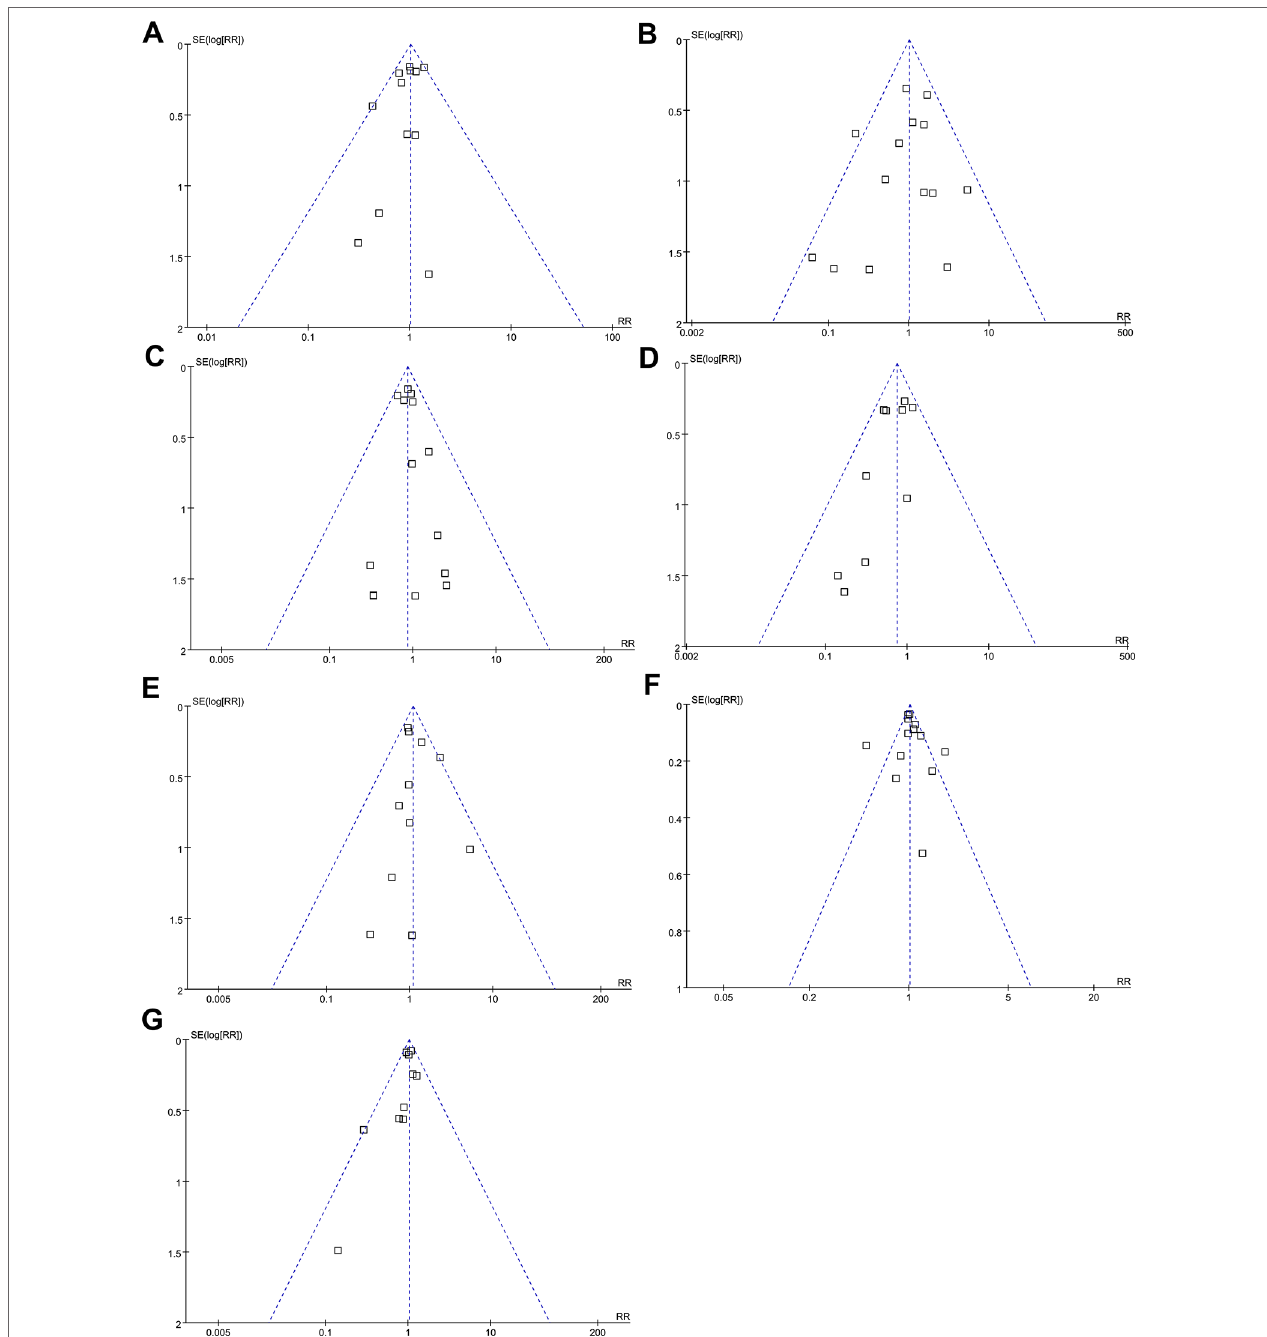
FIGURe 5 | Funnel plots for meta-analyses of the influence of vaptans on the clinical outcomes in cirrhosis patients. (A) Incidence of all-cause mortality. (B) Incidence of variceal bleeding. (C) Incidence of hepatic encephalopathy. (D) Incidence of spontaneous bacterial peritonitis. (E) Incidence of hepatorenal syndrome or renal failure. (F) Incidence of total adverse events. (G) Incidence of serious adverse